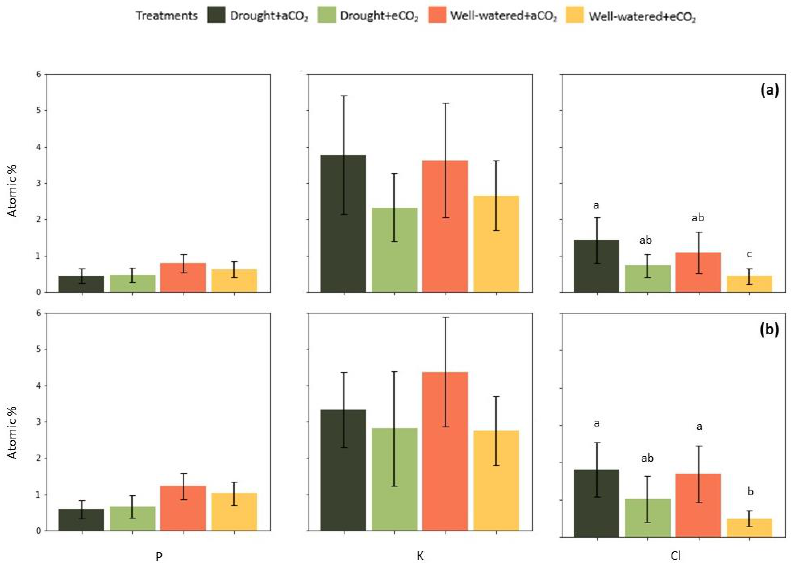
Figure 8. Effect of elevated CO 2 (950 ppm) and cyclic drought stress in the mean value of EDX spectrum ( ± confidential level of 95%) in Eucalyptus grandis ( a ) guard cells and ( b ) chloroplasts of the mesophyll cells at the end of the growth season. Different small letters indicate statistical significance between the means ( p <